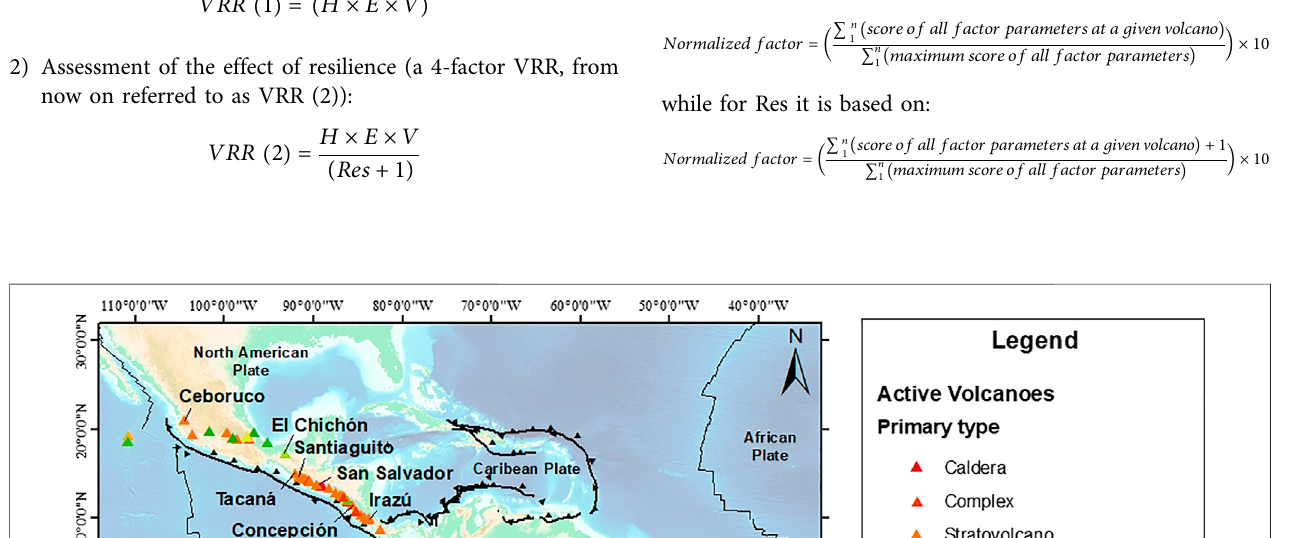
Frontiers in Earth Science |